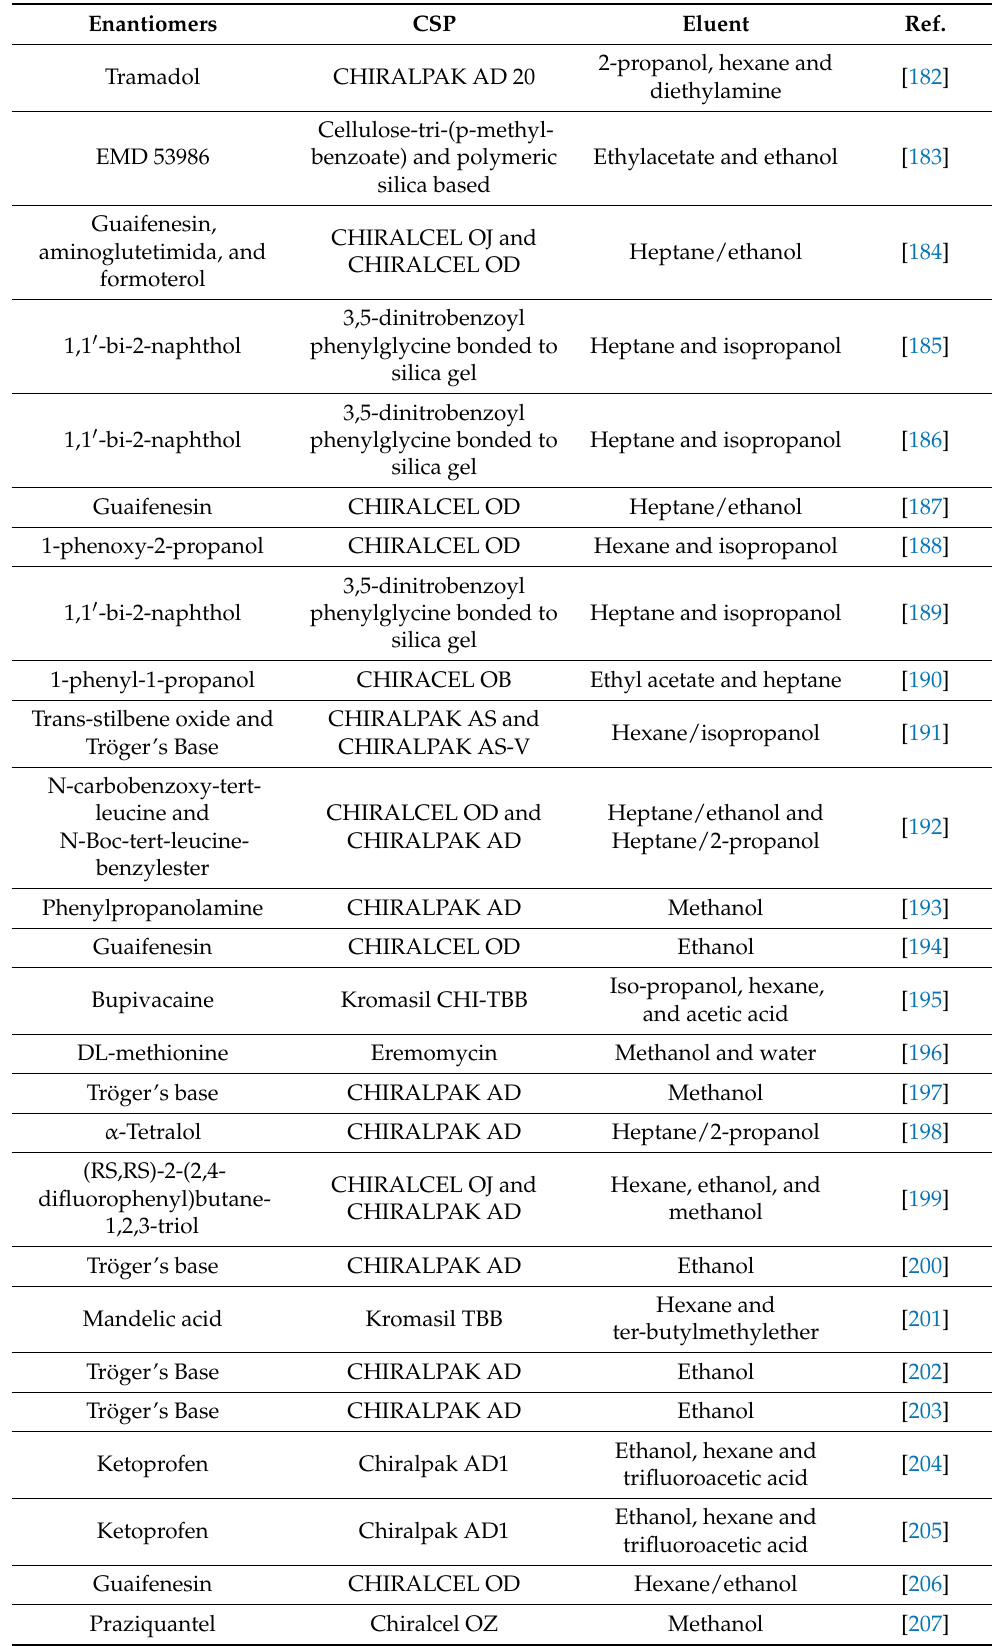
Table 11. Experimental studies of enantioresolutions applying SMB